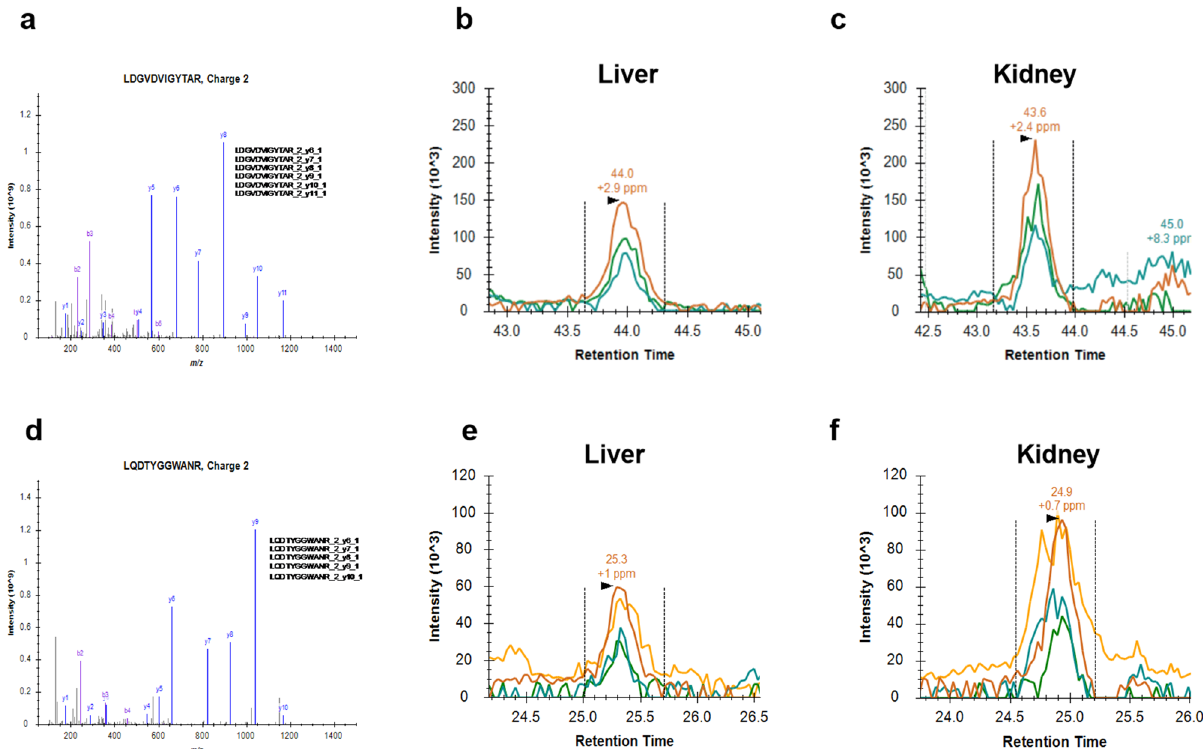
Figure 5. Detection of klotho protein in the liver of the Naked Mole Rat. Detection of klotho in the liver of the NMR with the kidney used as a positive control for klotho protein in Parallel Reaction Monitoring. ( a ) Mass spectrum with detected fragments obtained by analysis of a synthetic peptide (LDGVDVIGTAR), which is uniquely found in klotho. ( b , c ) Representative elution profile of the klotho unique peptide (LDGVDVIGTAR) in liver and kidney. ( d ) Mass spectrum with detected fragments obtained by analysis of a synthetic peptide (LQDTYG GWA NR) and its fragments. ( e–f ) Representative elution profile of (LQDTYG GWA NR), which is uniquely found in klotho in liver and kidney of NMR. n = 4 in each group. The detected mass deviation was less than 3 ppM. NMR: Naked Mole